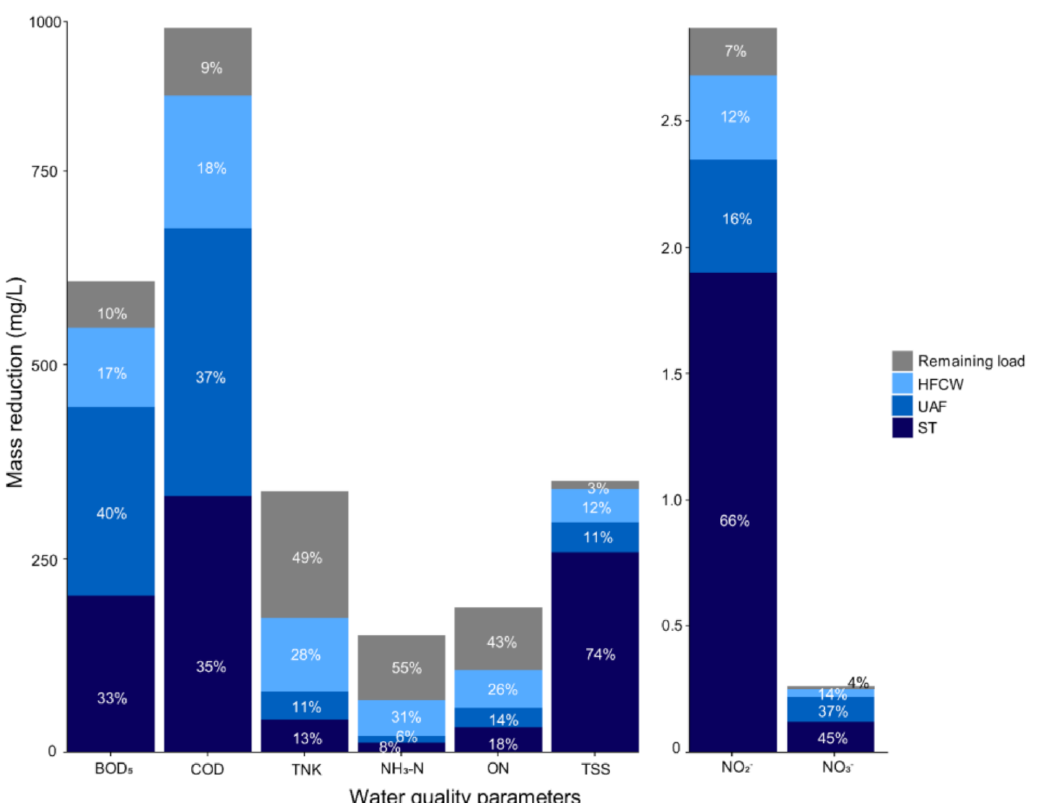
Figure 3. Removal efficiencies for each unit and the system overall. The image represents the mean of six observations taken fortnightly for three months (January to March 2020). ST: septic tank; UAF: up-flow anaerobic filter; HFCW: horizontal-flow constructed wetland; BOD 5 : biological oxygen demand; COD: chemical oxygen demand; TNK: total Kjeldahl nitrogen; NH 3 -N: ammoniacal nitrogen; ON: organic nitrogen; TSS: total suspended solids; NO 2 − : nitrites, and NO 3 − :